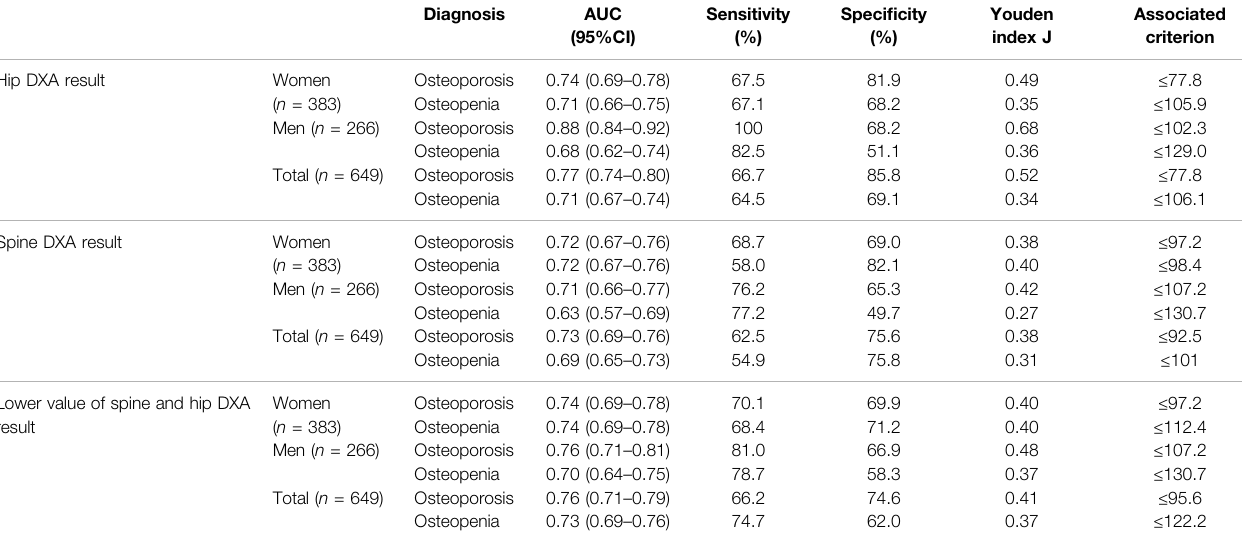
TABLE 4 | ROC analysis of QCT results with spine and hip DXA as the golden